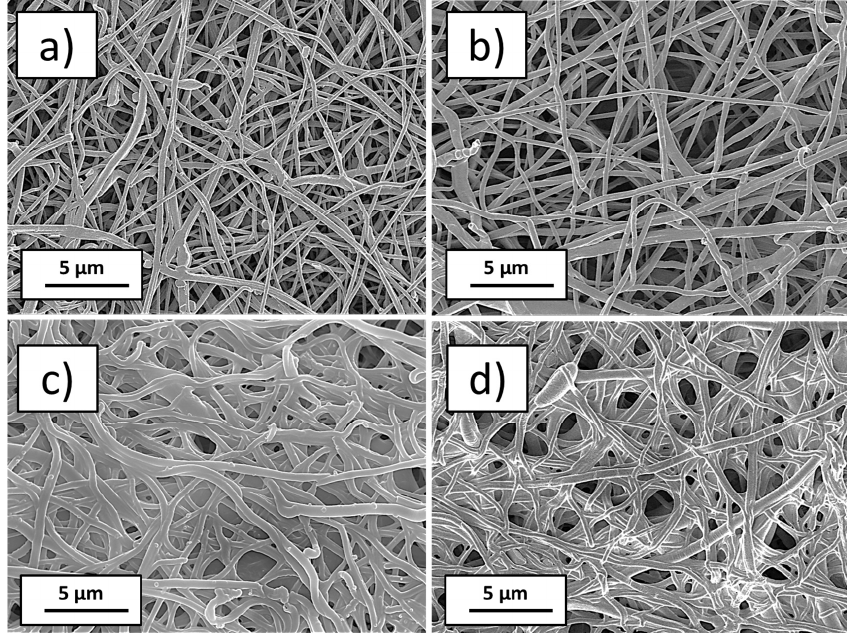
Figure 1. SEM micrographs at × 5000 magnification as prepared nanofibers PCL-ref ( a ), plasma-modified nanofibers PCL-COOH ( b ), plasma-modified nanofibers with immobilized PRP PCL-COOH-PRP ( c ), and plasma-modified nanofibers with immobilized PRP and after soaking in water at pH = 7, PCL-COOH-PRP-1d-pH7 ( d ). Table 1. Atomic composition of samples determined by XPS analysis.